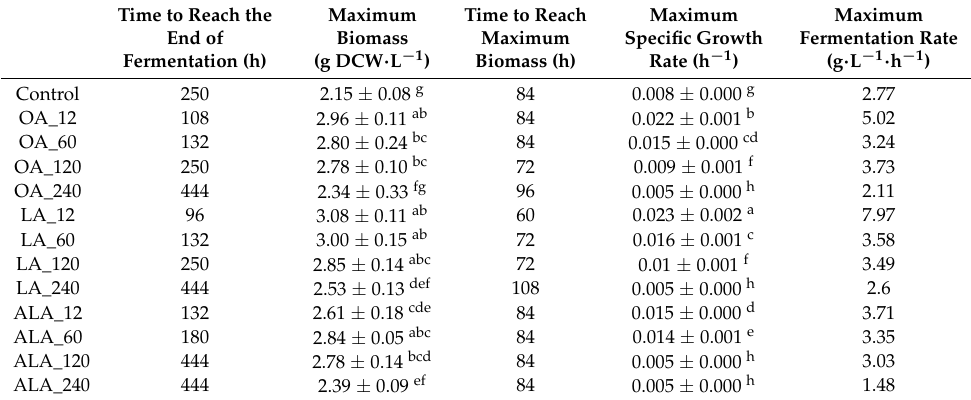
Table 1. Effect of different treatments on final fermentation